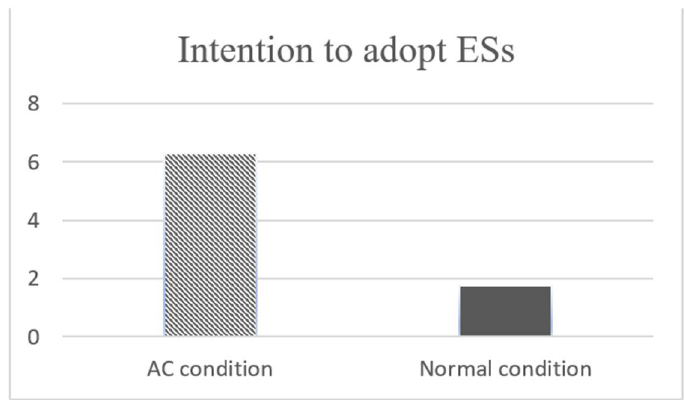
Figure 3. Intention to adopt ESs in Study